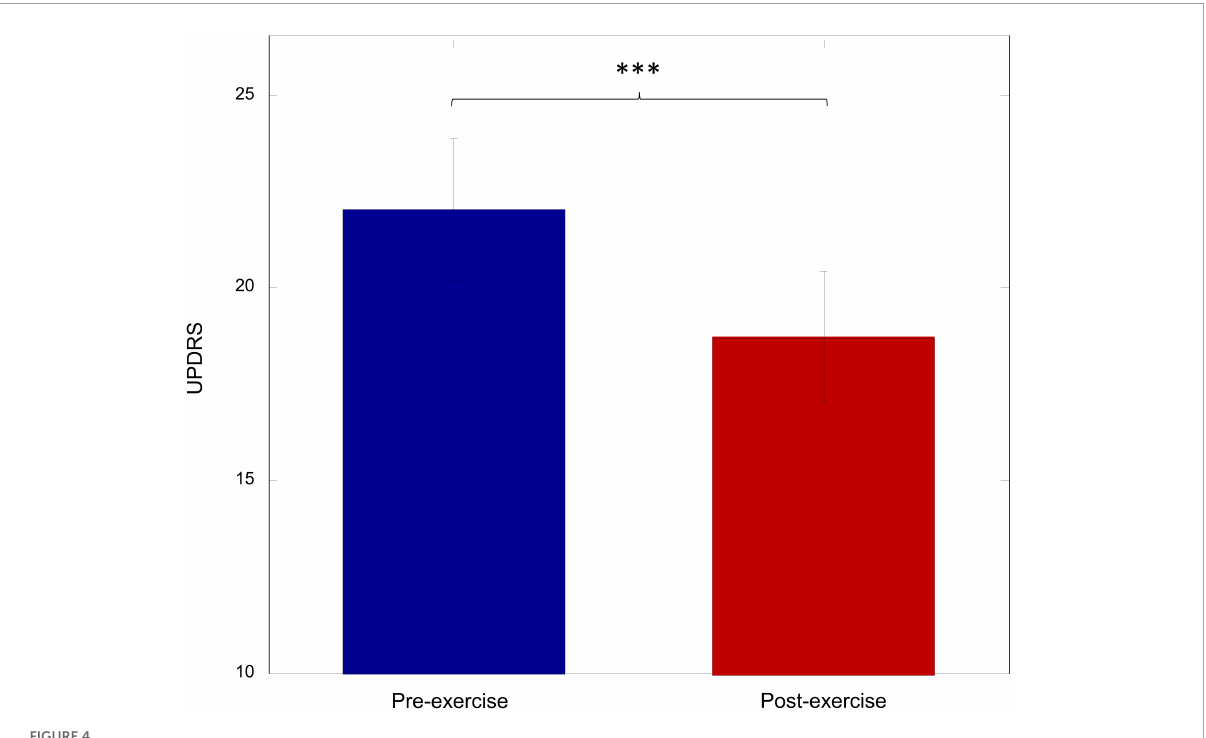
FIGURE4 The UPDRS score for pre-exercise and post-exercise ( ∗∗∗ p <